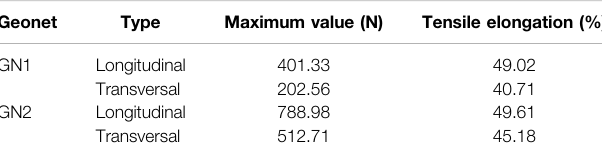
TABLE 2 | Tensile properties of the high-density polyethylene geonet.